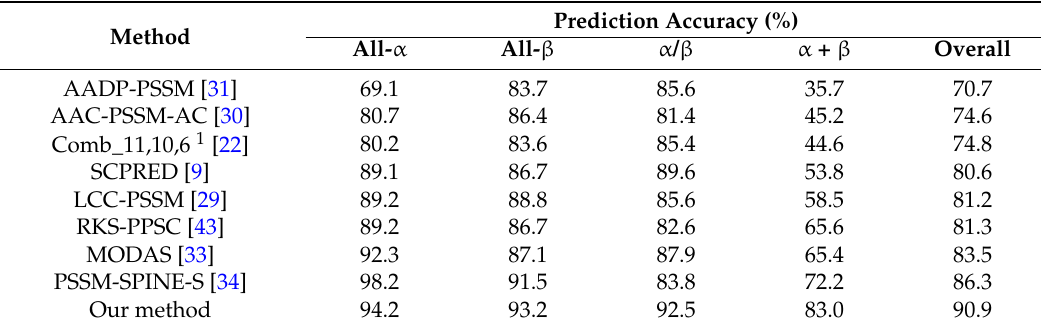
Table 4. Performance comparison of different methods on the 1189 dataset.